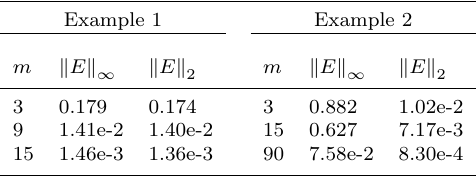
Table 2. Pad´e test for two benchmark problems Example 1